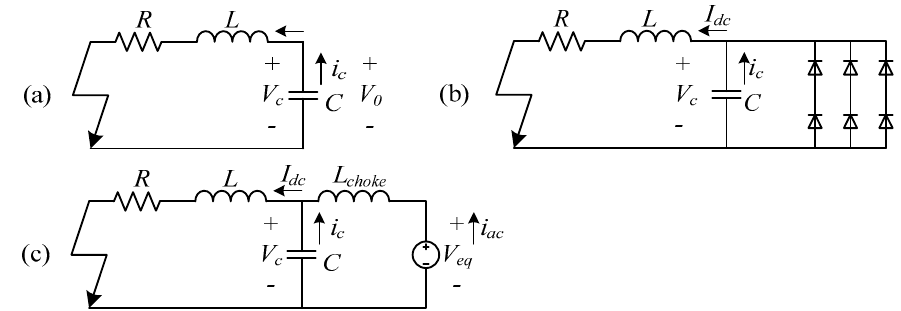
Figure 1. The equivalent circuits of different stages: ( a ) Stage 1: Capacitor discharge; ( b ) Stage 2: Diodes freewheel; and ( c ) Stage 3: Grid current feeding.